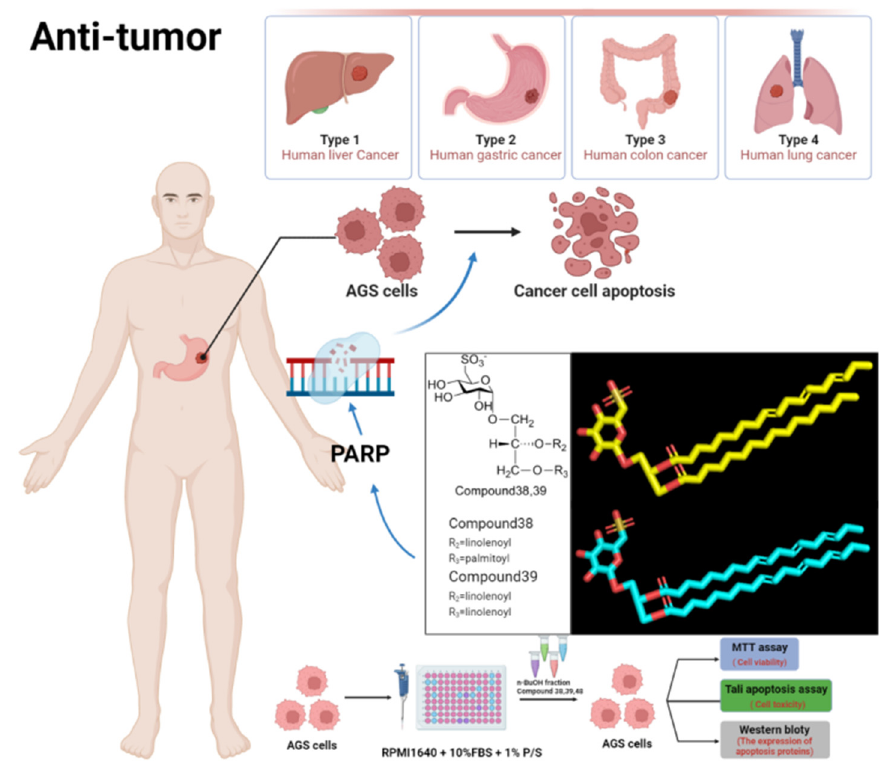
Figure 12. The anti-tumor effect of 2 glycosylglycerides identified from Fructus Malvae .